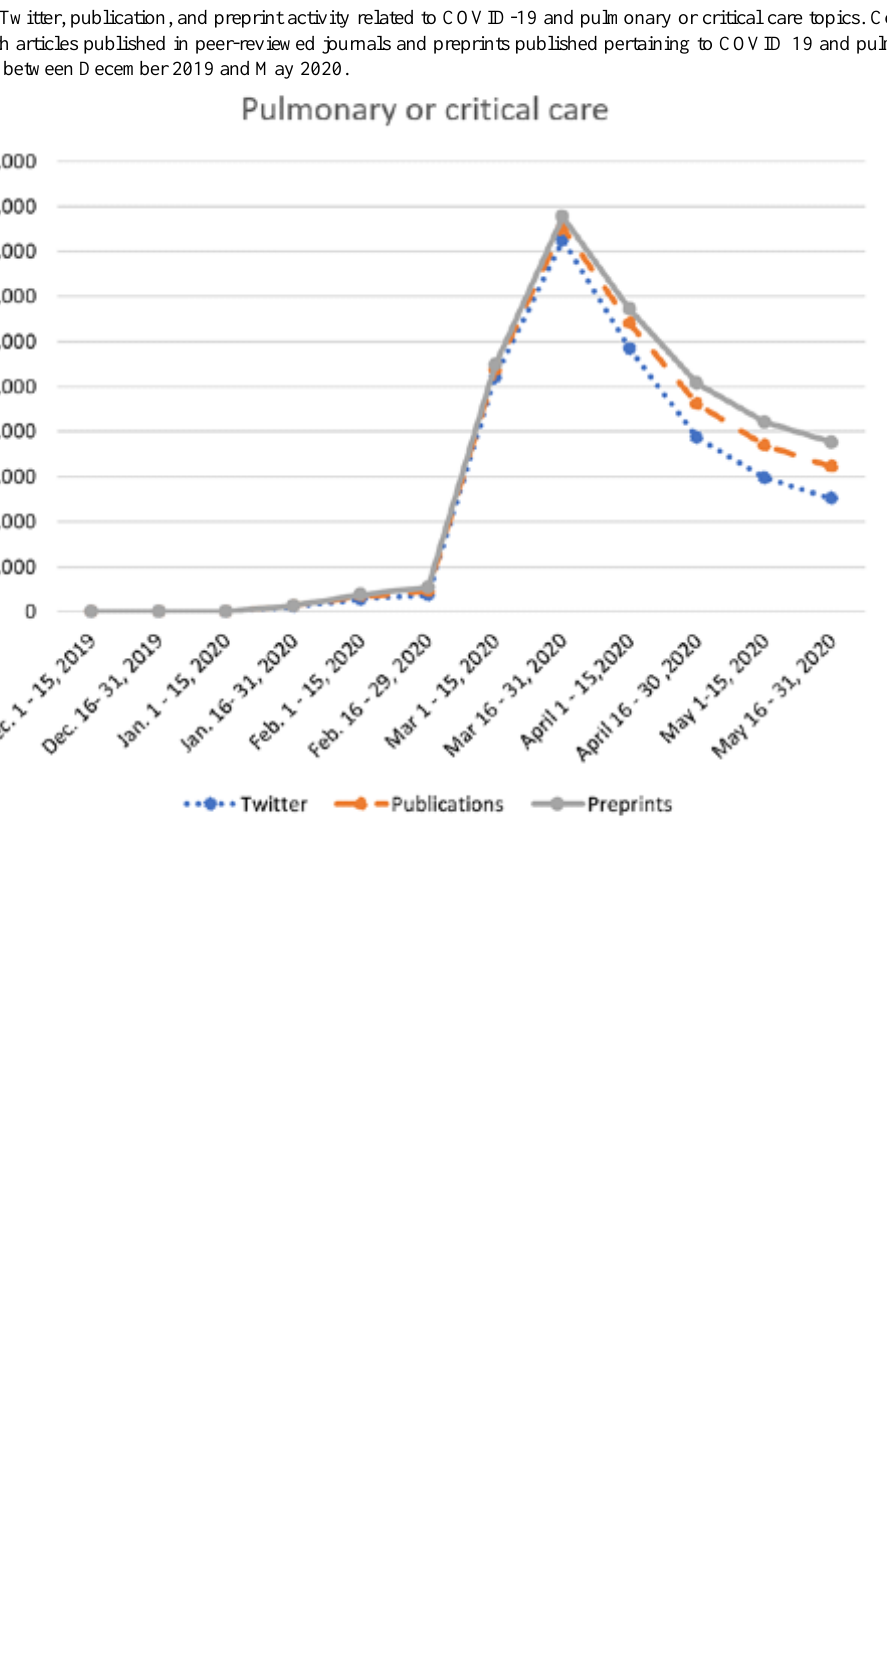
Figure 4. Trend of Twitter, publication, and preprint activity related to COVID-19 and pulmonary or critical care topics. Comparison of the